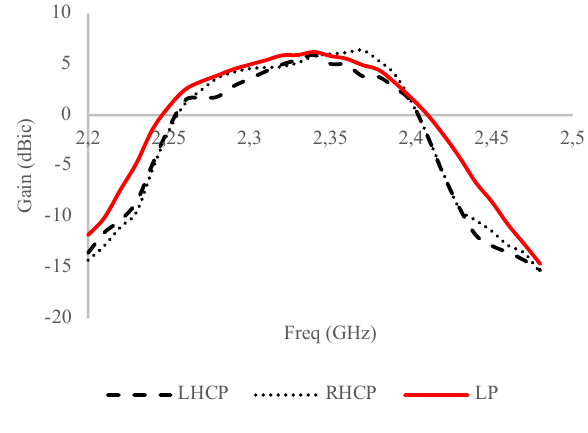
Figure 8: Measured gain across the operating band for LP and CP